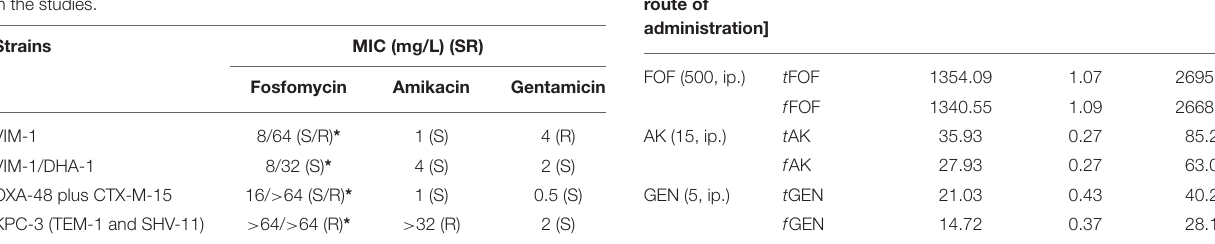
TABLE 3 | Pharmacokinetic profiles of fosfomycin, amikacin and gentamicin in mice serum. Antimicrobial [dose